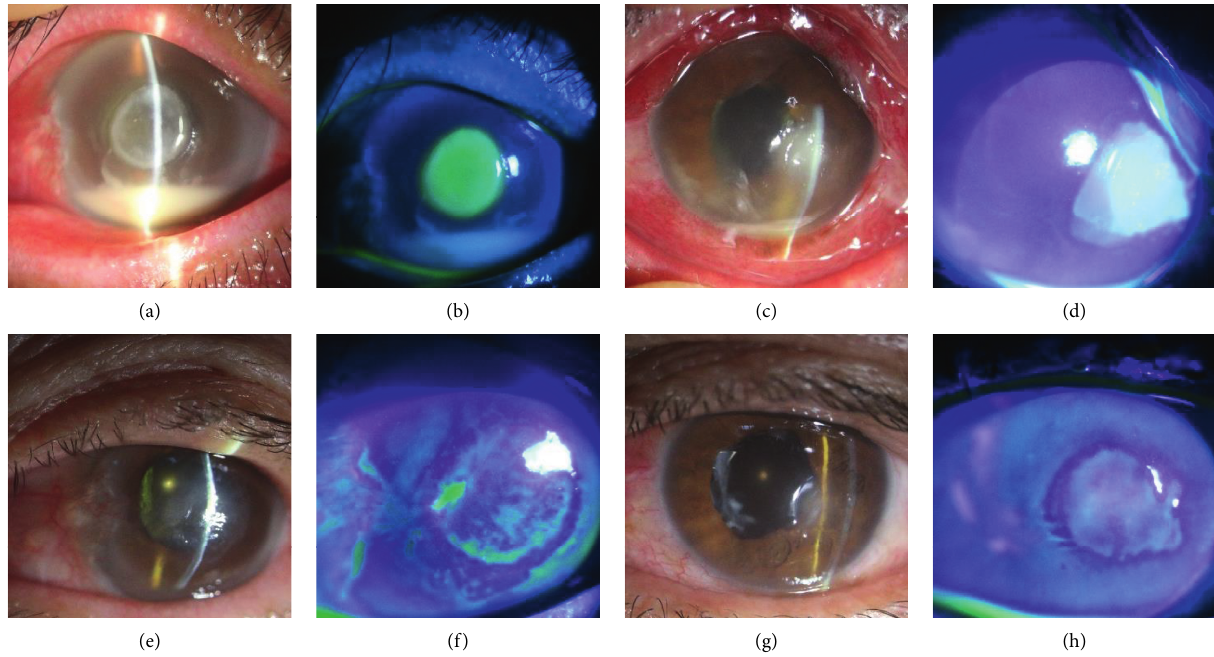
Figure 2: Representative cases of endophthalmitis caused by Moraxella species. In both cases, infectious keratitis was the predisposing factor. (a, b) Corneal edema, central infiltration, and epidefect were observed along with significant hypopyon at the initial visit. (c, d) Regressed central infiltration and epidefect after intravitreal antibiotic injection. (e, f) Conjunctival chemosis and injection, 4 ° /c corneal infiltration with epidefect, pupillary membrane, and hypopyon were seen. (g, h) Pars plana vitrectomy and intravitreal antibiotic injection were performed, and the endophthalmitis has cleared